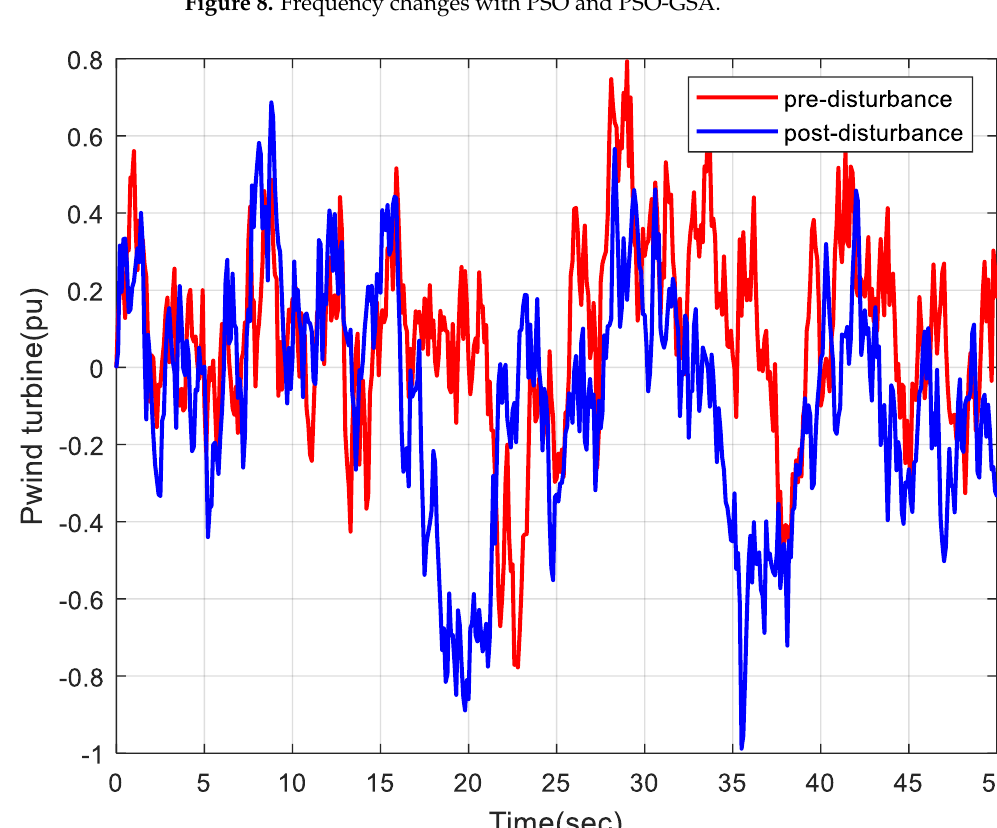
Figure 8. Frequency changes with PSO and PSO-GSA.